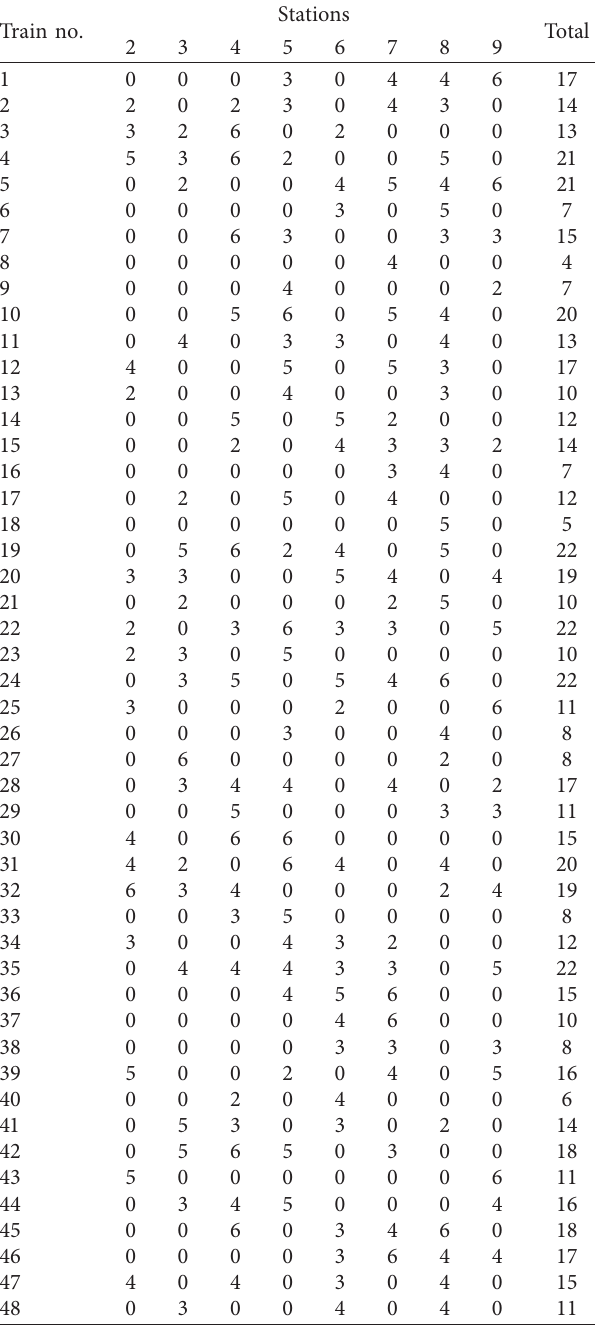
Table 6: The optimized dwelling times for each train (min). Train no.